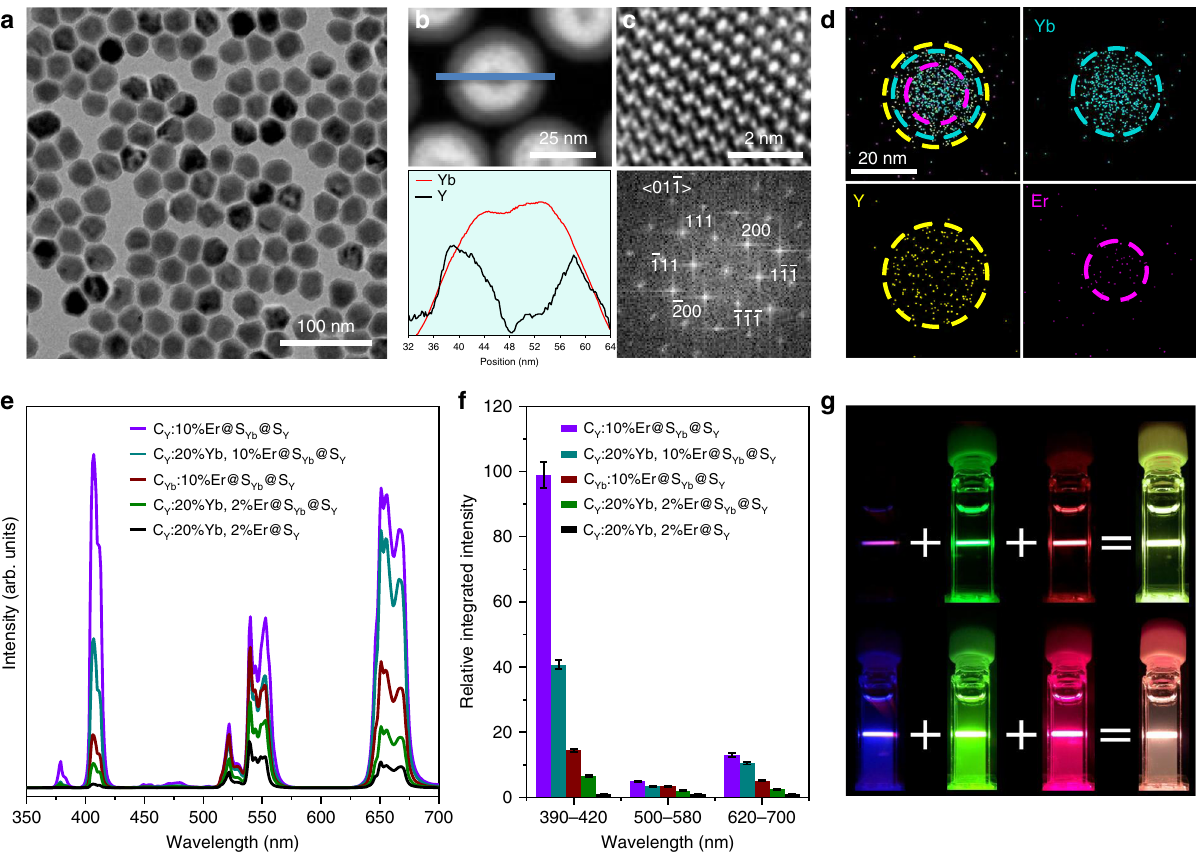
Fig. 2 Ef fi cient multiphoton upconversion in trilayered nanoparticles. a – d TEM ( a ) and high-resolution STEM images ( b , c ) revealing the single- crystalline nature of the α -NaYF 4 :Er@NaYbF 4 @NaYF 4 nanocrystal ( d SYb = 8.3 ± 0.7 nm, d SY = 2.3 ± 0.1 nm). The d SYb and d SY are used to designate the thickness of the intermediate NaYbF 4 and the outmost NaYF 4 shells, respectively. The EDX results ( b , d ) show distribution of Er 3 + , Yb 3 + and Y 3 + ions, consistent with the core-shell-shell structure. Nanoparticles with d SY = 5.6 ± 0.7 nm were selected for better contrast in b . e Upconversion emission spectra (collected with the mode of “ emission correction off ” ) for different UCNPs upon 980-nm excitation (24.0 W cm − 2 ): C Y , C Yb , S Yb and S Y are used to designate NaYF 4 core, NaYbF 4 core, NaYbF 4 shell and NaYF 4 shell, respectively. For C Y :20%Yb, 2%Er@S Y , d SY = 10.5 ± 0.8 nm. f , g The PL intensities ( f